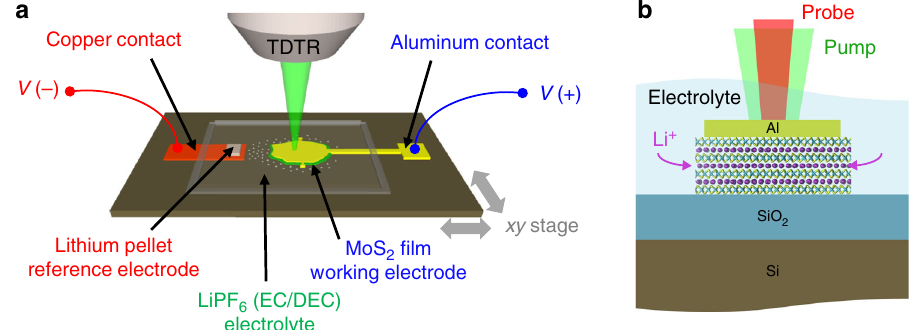
Fig. 1 Experimental measurement of a thermal transistor. a Schematic of the electrochemical cell used for operando TDTR experiments. b Cross-sectional view of a device under operation. Li ions enter and leave the MoS 2 fi lm through the exposed